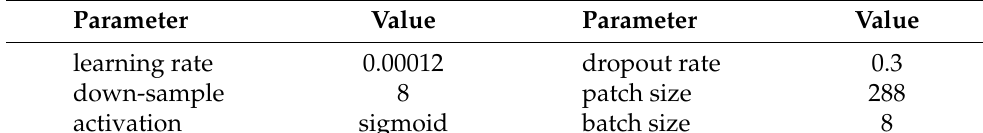
Table 1. Summary of deep learning model parameters.